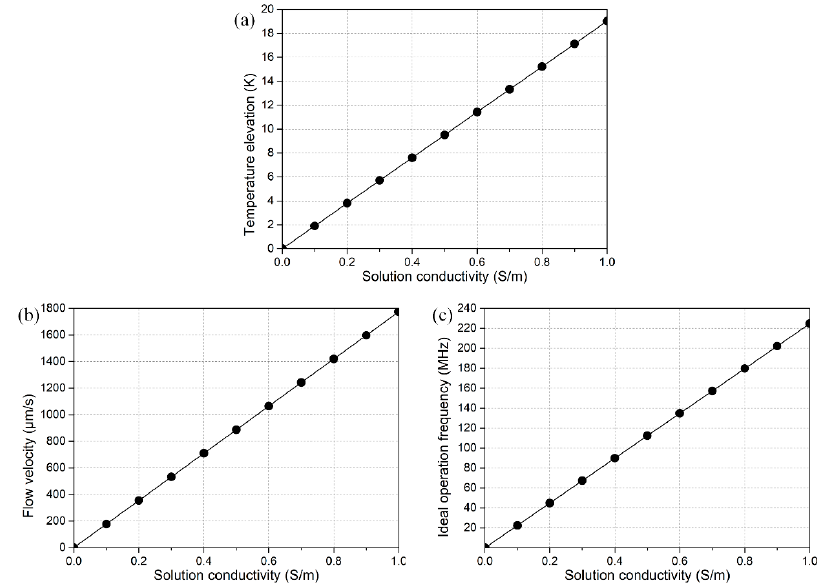
Figure 7. Numerical prediction on conductivity-dependence of the device performance, including ( a ) the maximum temperature elevation; ( b ) electrothermal flow velocity; and ( c ) ideal operation frequency.